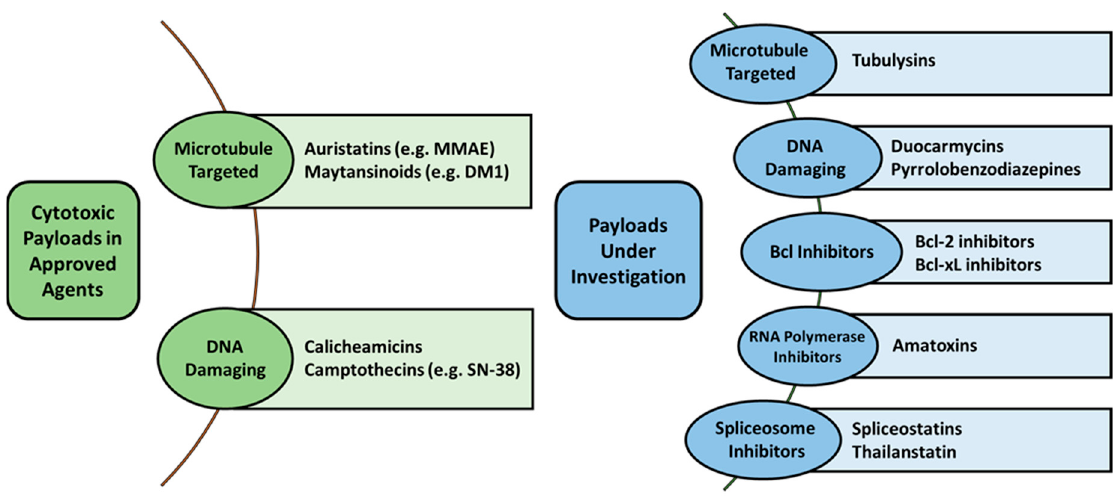
Figure 1. Overview of cytotoxic payloads conjugated to approved ADCs and ADCs in development.